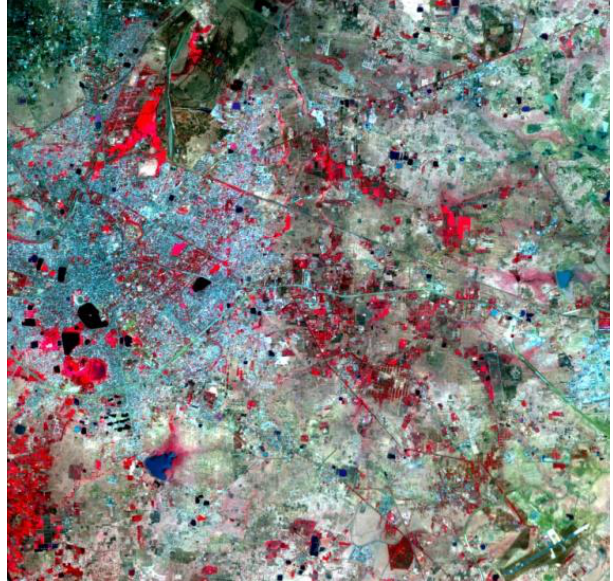
Figure 1. Atmospheric Corrected FCC Resourcesat-1